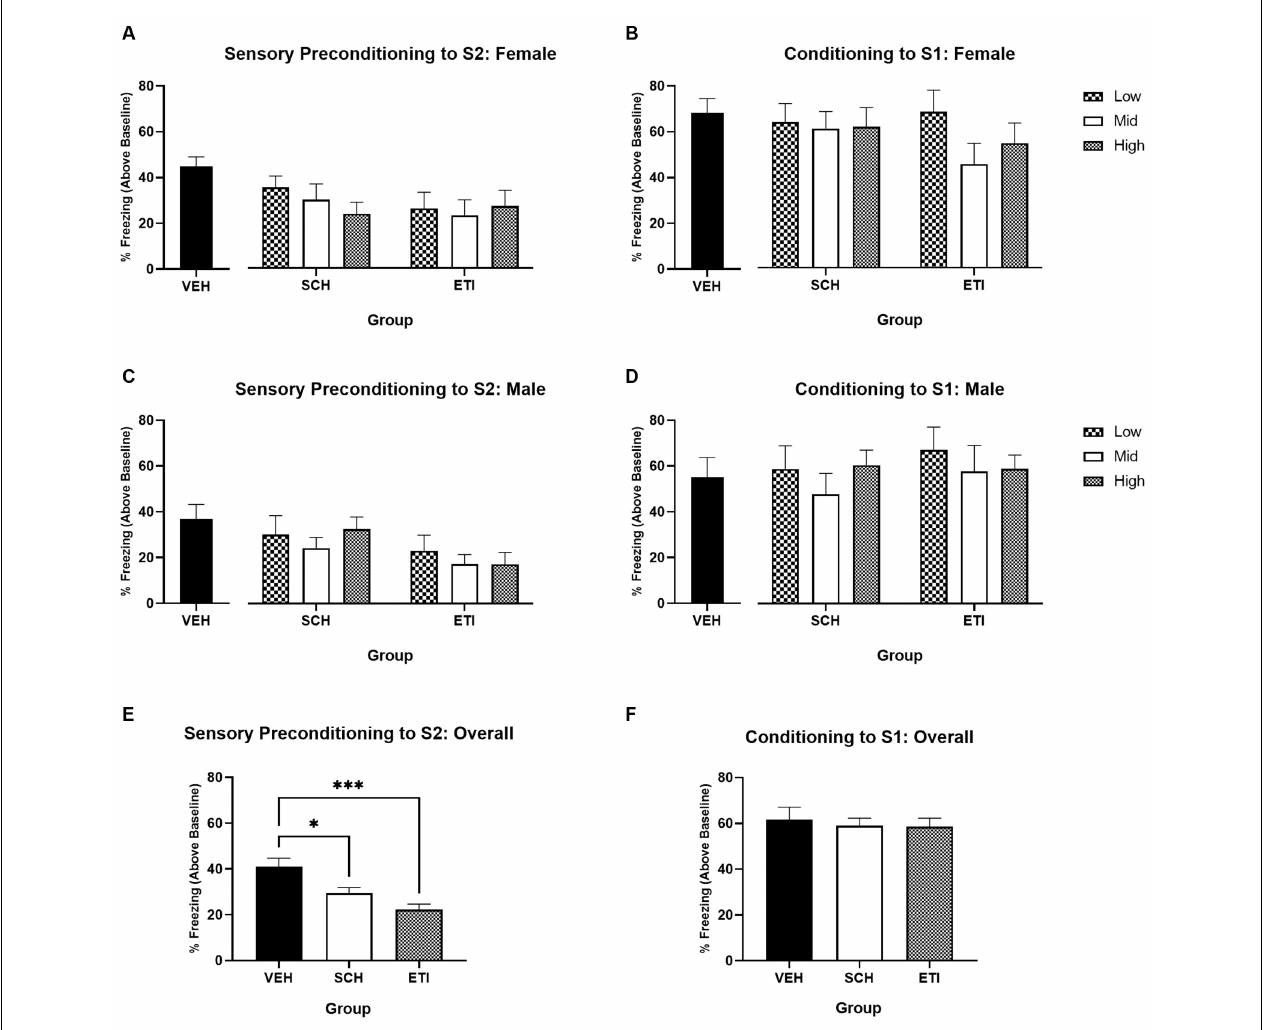
FIGURE 3 | Sensory preconditioning under conditions of dopamine receptor antagonism in male and female rats. Training in a neutral context. Panels (A,C) show average per cent time spent freezing in response to S2 (stimulus—baseline) on the test of sensory preconditioning in groups of female vs. male rats, respectively. Panels (B,D) show average per cent time spent freezing to S1 (stimulus—baseline) on the test of first-order conditioning in groups of female vs. male rats, respectively. In Panels (A–D) , black bars indicate treatment with saline vehicle, black and white chequered bars indicate treatment with the low-dose antagonist, white bars indicate treatment with the mid-dose antagonist, and grey hashed bars indicate treatment with the high-dose antagonist. Panels (E,F) show the average per cent time freezing (stimulus—baseline) during tests of S2 and S1 respectively, collapsed across dose and sex. Vehicle-treated rats (VEH; n = 16) froze significantly more than SCH39166- (SCH; n = 39) or eticlopride-treated rats (ETI; n = 36). Error bars represent ± SEM. Significant comparisons are indicated by: ∗ where p < 0.05; ∗∗∗ where p <